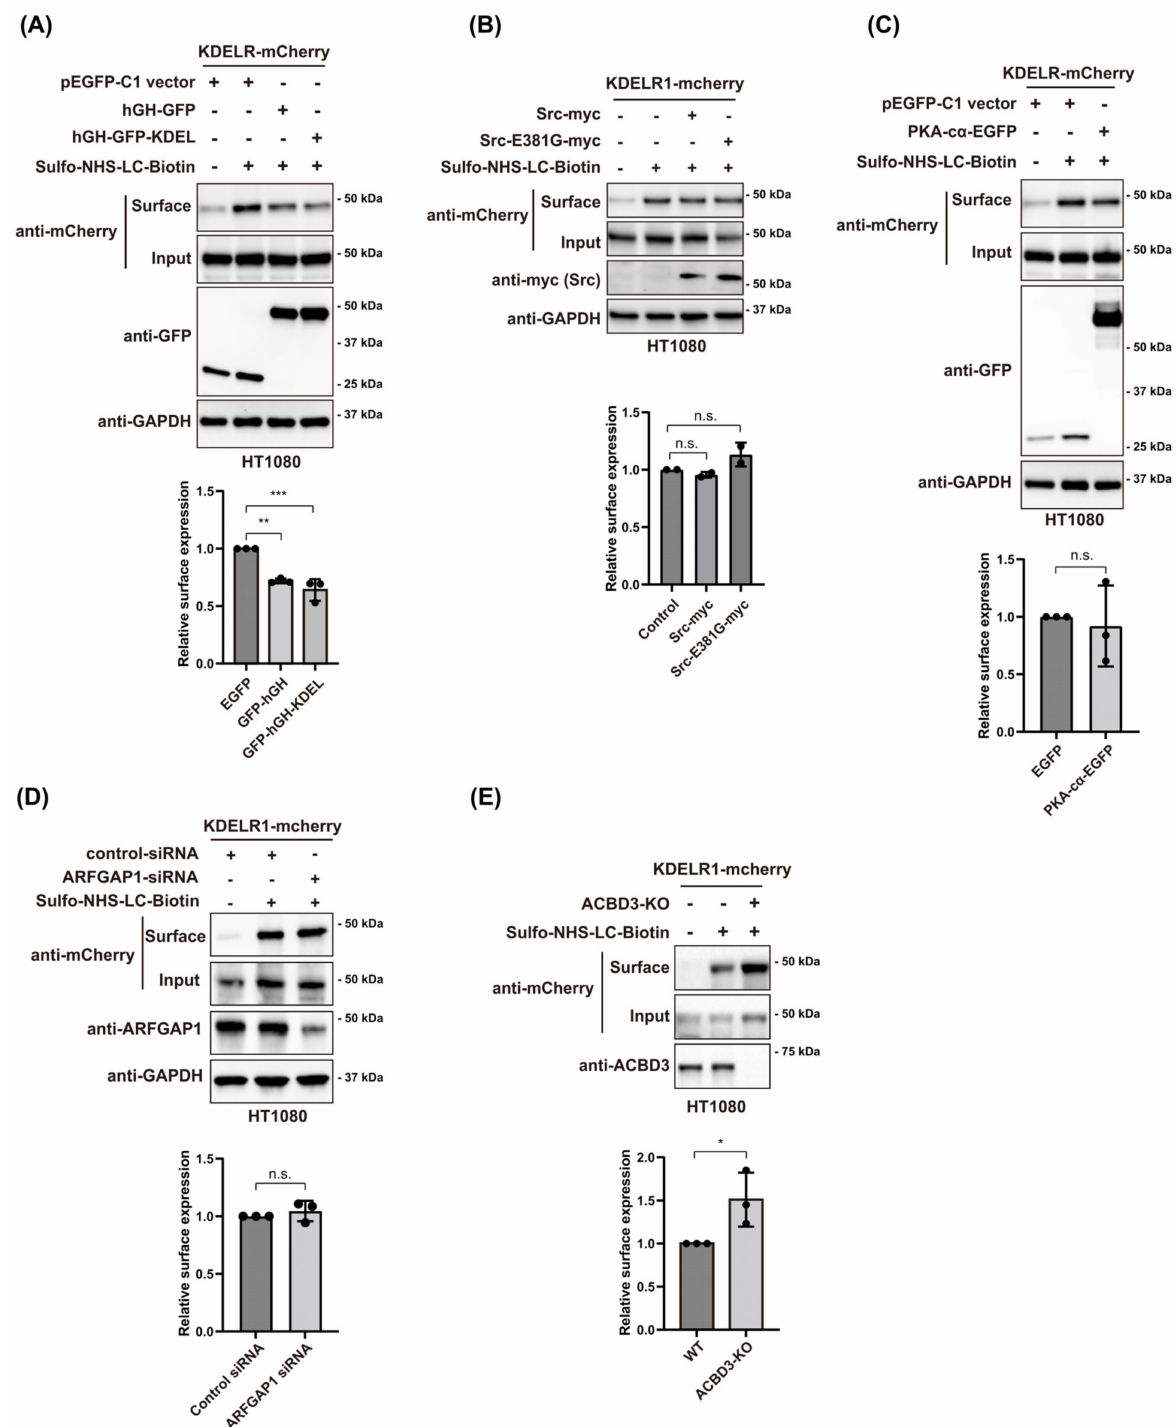
Figure 1. A small scale screening of regulators of KDELR transport to the plasma membrane. ( A ) Expression of hGH-GFP-KDEL causes decreased surface expression of KDELR1-mCherry com- pared to GFP or hGH-GFP control. HT1080 cells were co-transfected with KDEL-R1-mCherry and hGH-GFP-KDEL, hGH-GFP or GFP control and cell surface expression of KDEL-R1-mCherry was detected via cell surface biotinylation. The normalized cell surface level of KDEL-R-mCherry using den- sitometric analysis is shown at the bottom. Statistical analysis was performed using one-way ANOVA with a Tukey’s post hoc test (mean ± SD; **, p < 0.01; ***, p < 0.001). ( B ) HT1080 were co-transfected with KDEL-R1-mCherry and Src-WT or a constitutive active mutant E381G, followed by cell surface biotinylation. Biotinylated proteins were isolated using streptavidin-agarose and subjected to